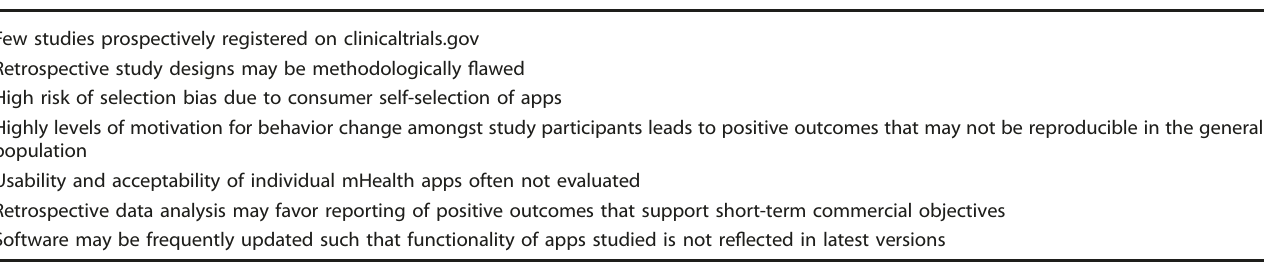
Table 2. Limitations of retrospective analyses of patient generated outcomes in